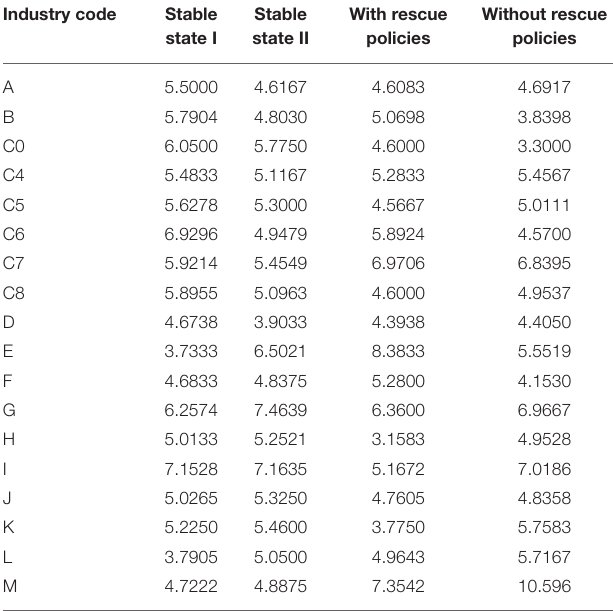
TABLE 3 | Average degrees of constituent stocks in the SSE180 index for each industry during two stable-state sub-periods and sub-periods with and without rescue policies.